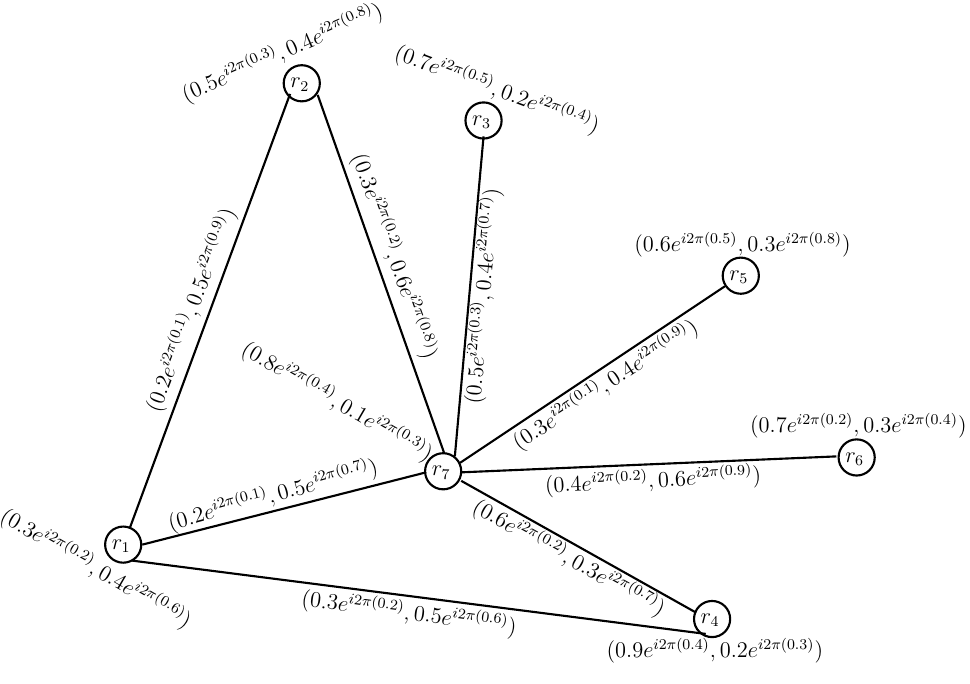
Figure 13: The relationships among the factors r i ( i = 1 , 2 , . . ., 7).